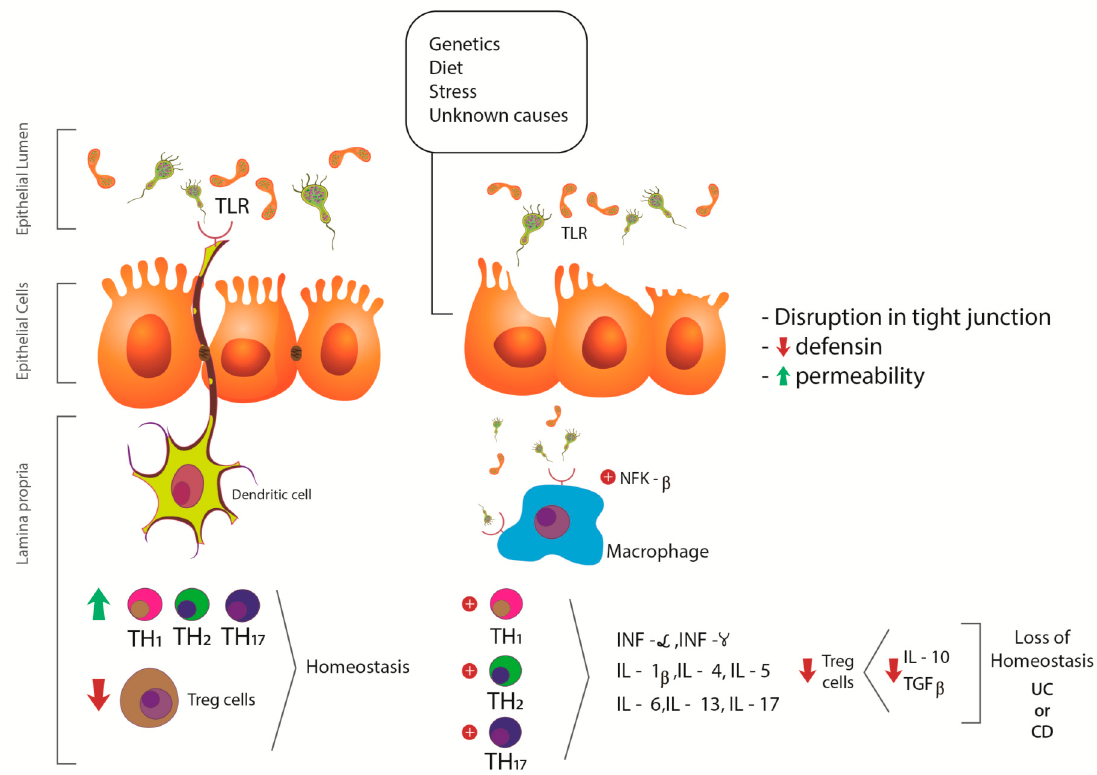
Figure 2. Pathophysiologic aspects of UC and CD. Genetic and environmental factors may be related to the disruption in tight junctions and the increase in permeability, leading to an abnormal immune response. The consequences are imbalanced stimulation of TLR and NF κ - β , leading to overexpression of pro-inflammatory biomarkers (IL-1 β , IL-4-6, IL-17, TNF- α , and INF) and reduced expression of IL-10 and TGF- β . TLR: Toll like receptor; NFk- β : nuclear factor kappa-beta; INF- γ : interferon- γ ; TNF- α : tumor necrosis factor- α ; IL: interleukin; TH: T helper cell; Treg cells: T regulatory cells; UC: ulcerative colitis; CD: Crohn’s disease.